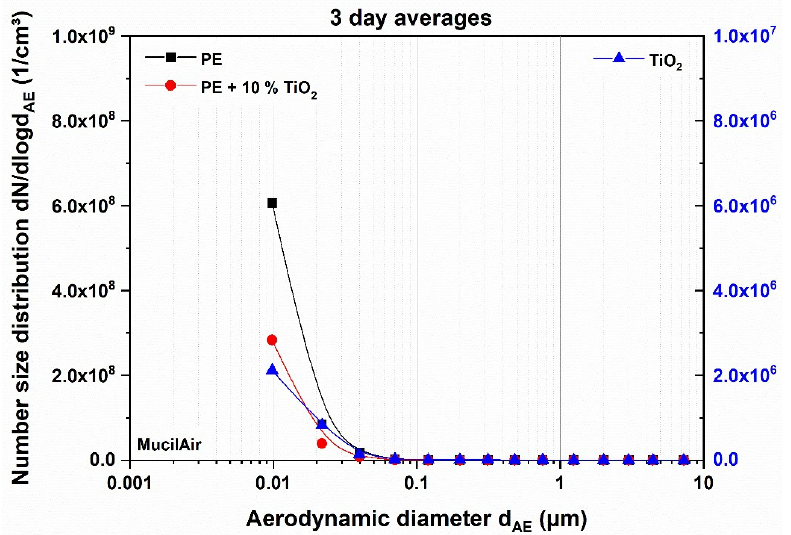
Figure 4. Average number size distributions of nanocomposite and nanoparticle materials down- stream of the thermal treatment, tested in MucilAir™ tissue. The polymer-based materials refer to the left axis, the TiO 2 particles to the right axis.